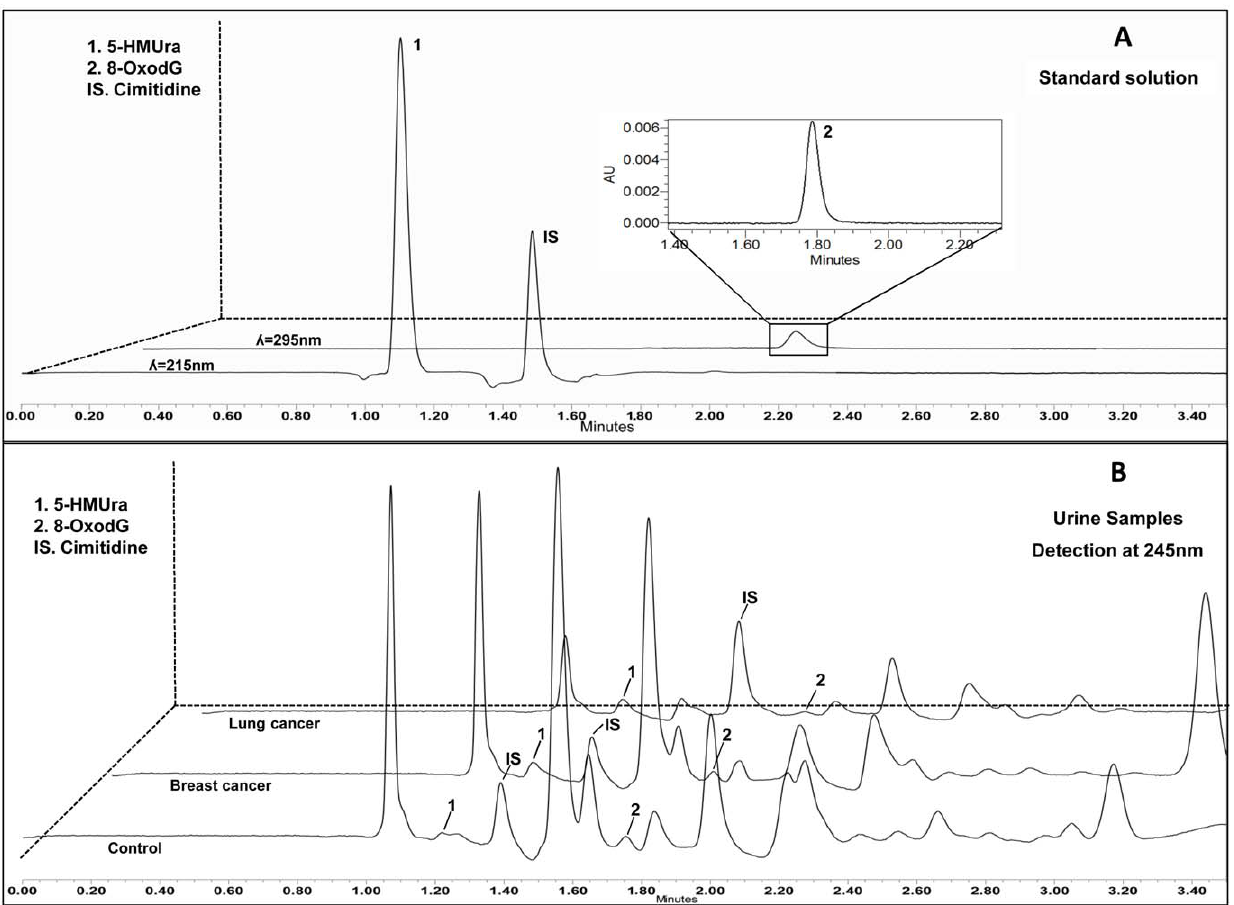
Figure 3. Representative UHPLC-PDA chromatograms of a biomarker standard solution (5-HMUra at 0.0025 m g mL 2 1 ; 8-oxodG at 4 m g mL 2 1 ) (A), and from urine of control subjects and cancer (lung and breast) patients (B).